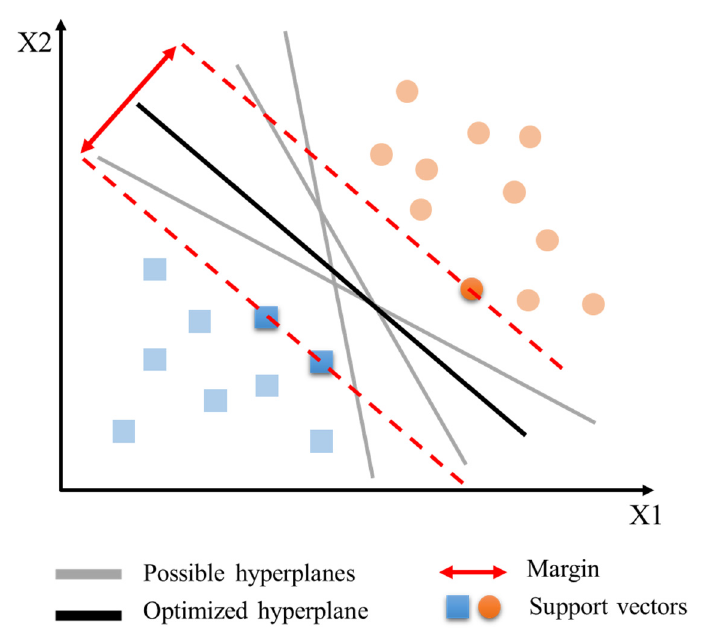
Figure 9. A conceptual description of SVM classification.